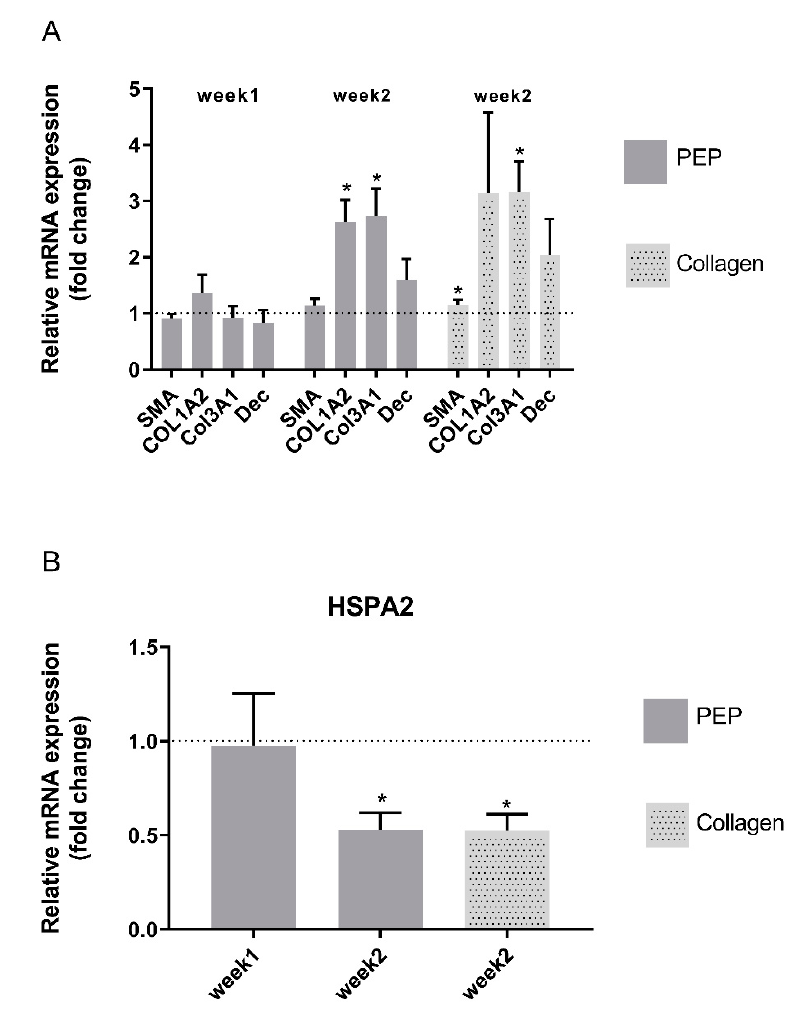
Figure 5. mRNA expression of ECM components and stress markers of fibroblasts cultured in a collagen scaffold with and without PEP. Fibroblasts differentiation and extracellular matrix production ( A ) is increased together with reduced stress marker HSP ( B ) in both scaffolds after long- term culturing for two weeks. Bars shows relative mRNA levels presented as fold change ( ΔΔ Ct) in PEP scaffold/collagen scaffold (week 1). Collagen scaffold (week 1) is set to 1 (represented as dotted line). Data are presented as mean ± stdv from three independent cell experiments seeded out in duplicates * Significant difference compared to fibroblast cultured on a collagen scaffold for one week determined by one-way ANOVA using Dunnett’s multiple comparison test.